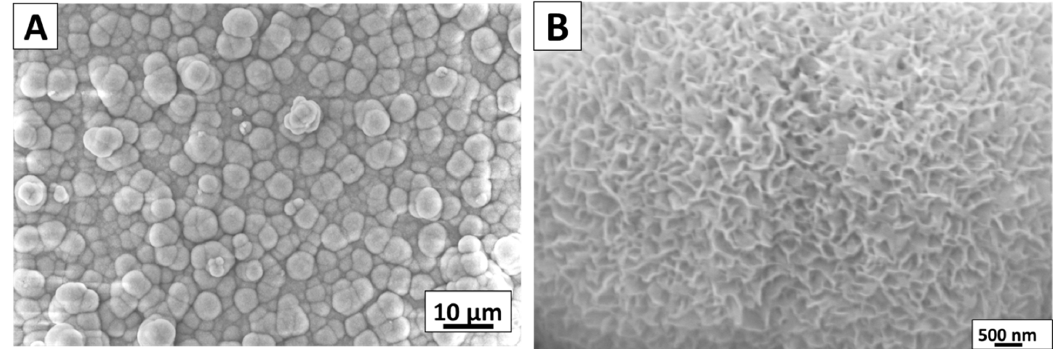
Figure 9. SEM images of Ag-Sr MBGNs pellets after immersion in SBF for 7 days, ( A ) low-magnification image, ( B ) higher magnification image. Studies show that bone reformation is pH-sensitive. During bone remodeling around the border of osteoclast, pH is 4.0 and the pH of surrounding body fluid is 7.4